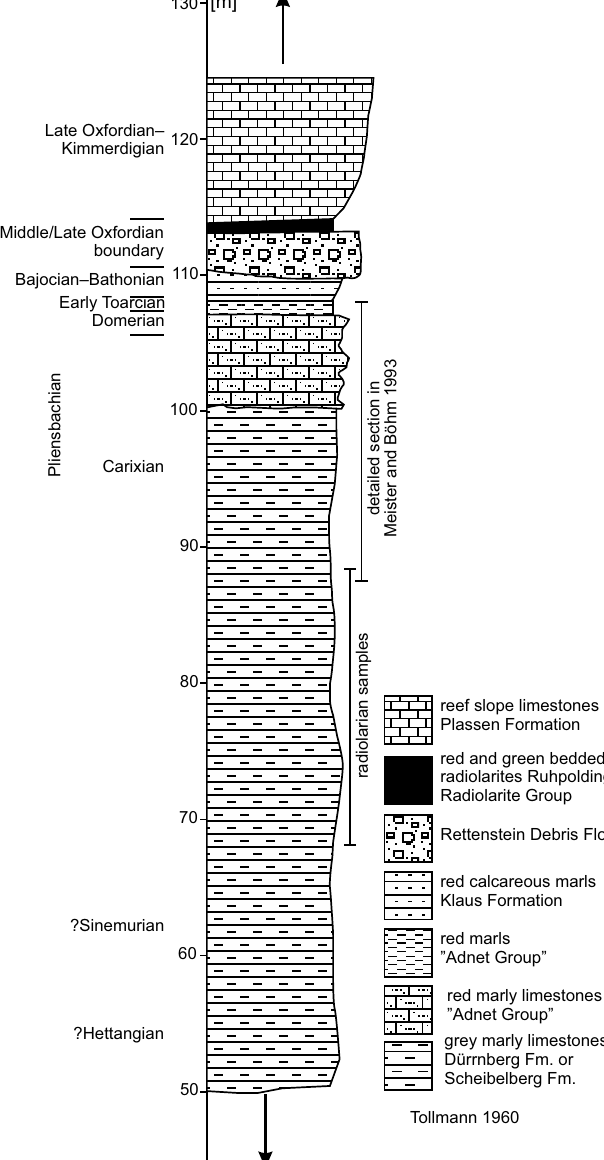
Fig. 4. Stratigraphy and lithology of the Mount Rettenstein succession sensu